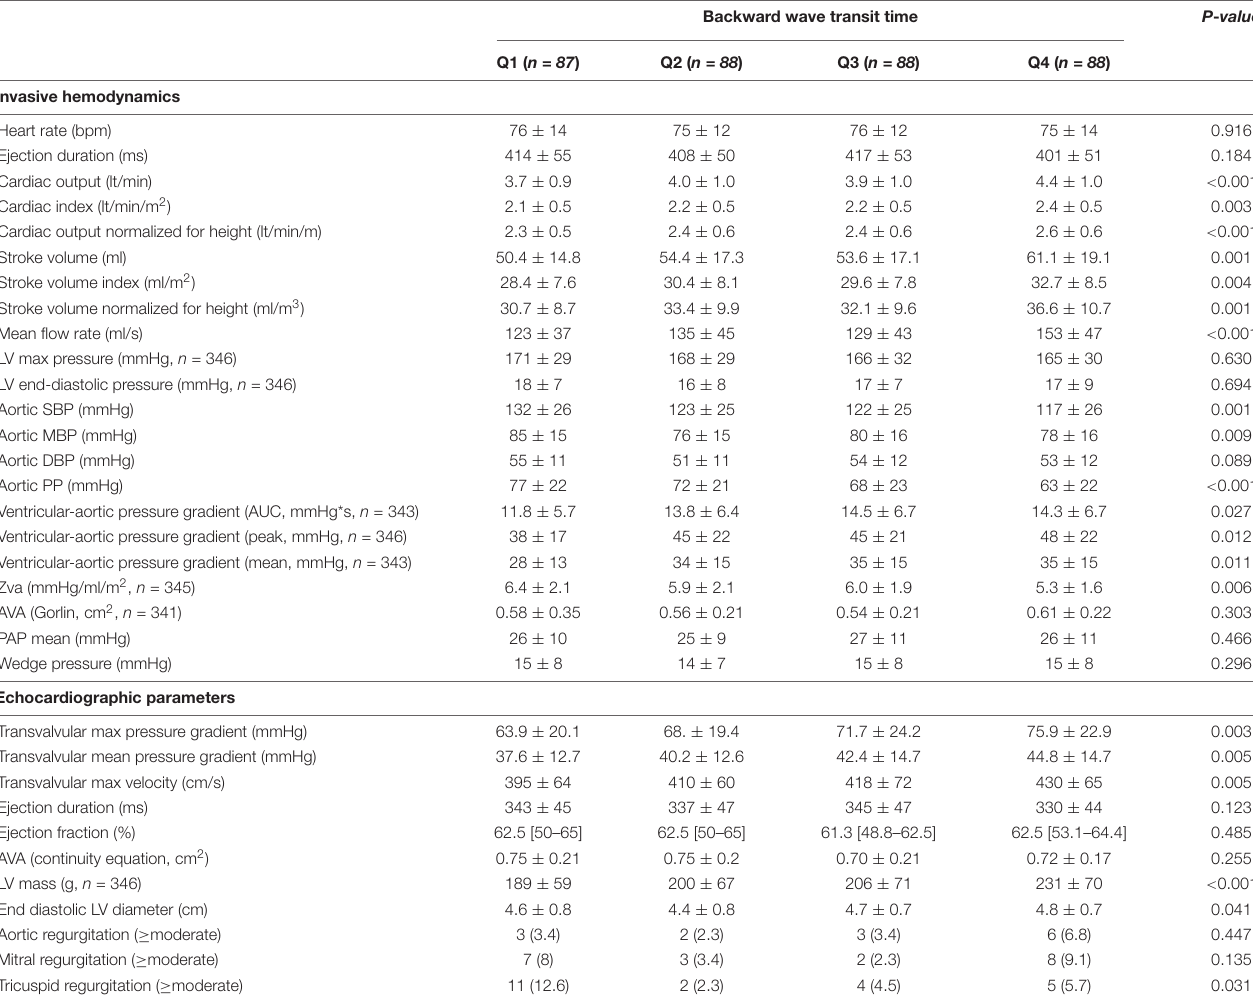
TABLE 2 | Invasive and echocardiographic parameters according to the BWTT